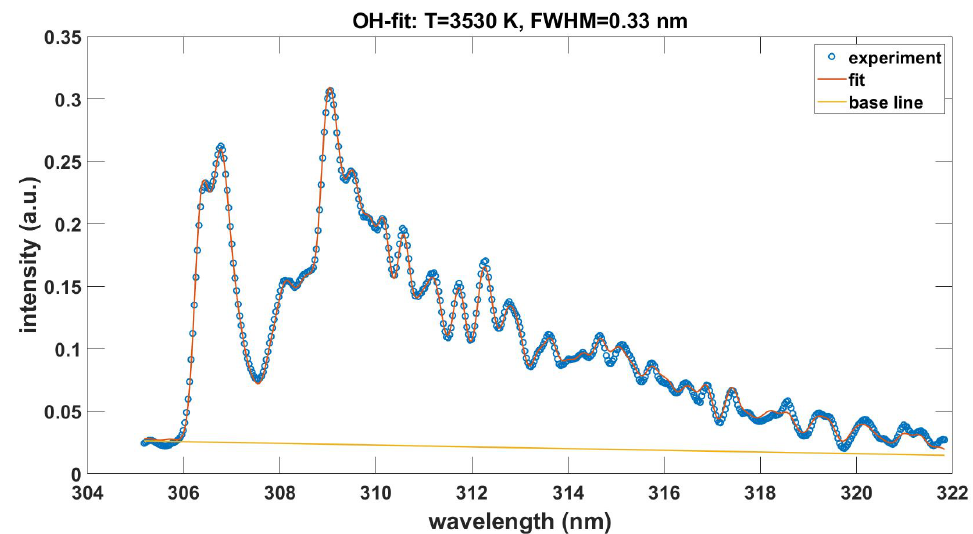
Figure A1. Measured and with OH-LSF.txt fitted OH emission spectra, ∆ v = 0, δ λ = 0.33nm, T =